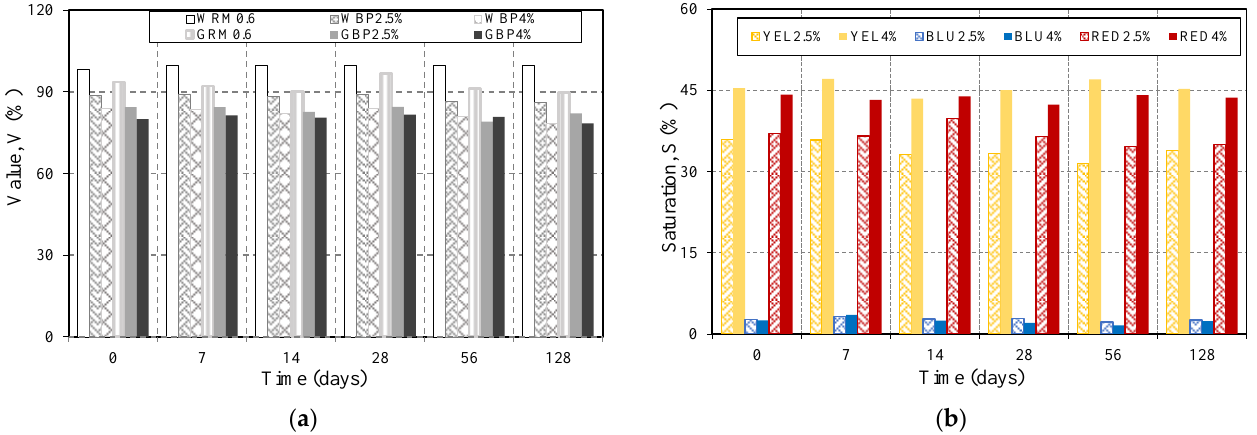
Figure 8. Chromatic characterisation: ( a ): Value (WRM0.6, WBP2.5%, WBP4%, GRM0.6, GBP2.5, GBP4%); ( b ): Saturation (YEL2.5%; YEL4%; BLU2.5%; BLU4%, RED2.5%, RED4%).